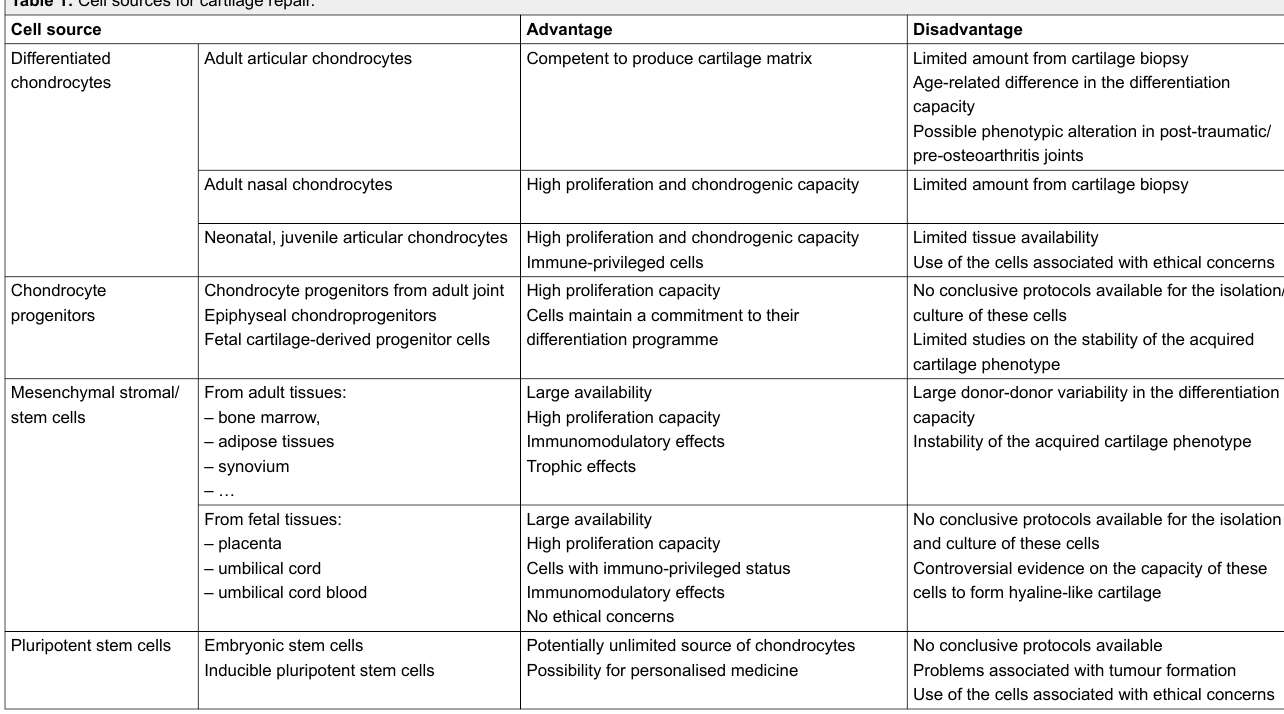
Table 1: Cell sources for cartilage